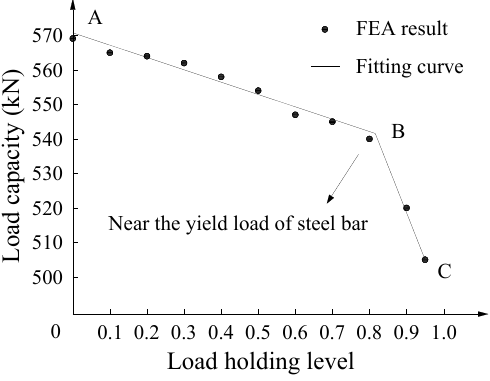
Figure 19. Effect of load holding level.